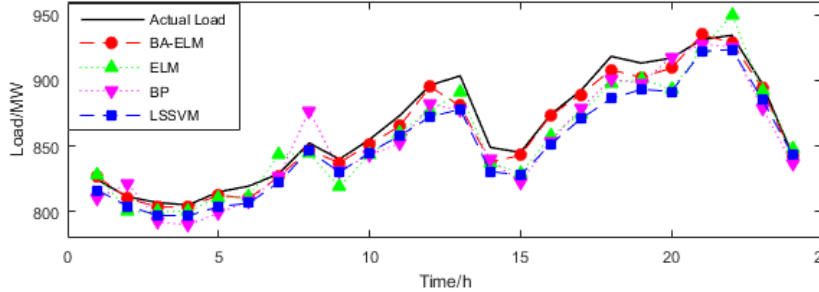
Figure 8 . Compared load forecasting results on 28 June.